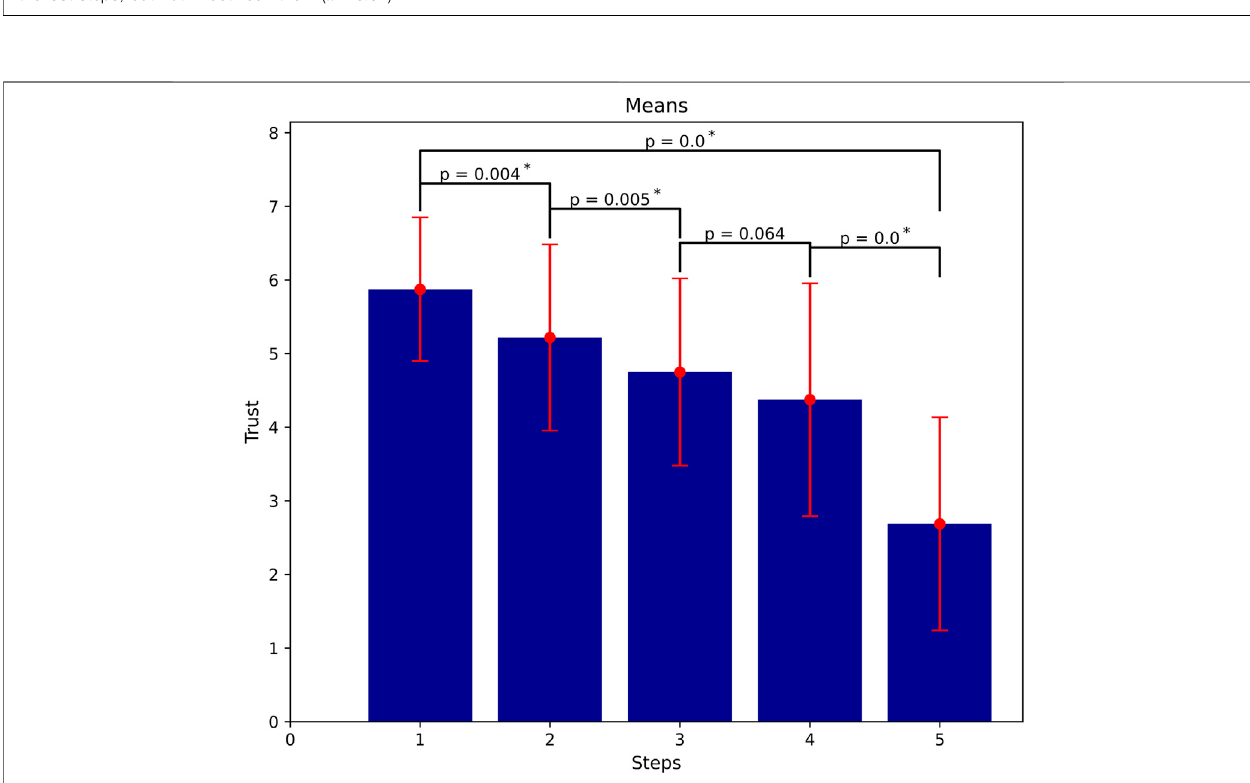
FIGURE 6 | Trust dissipation as more failures occur (means of trust at all steps). Signi fi cant loss of trust mostly even in between steps ( α (cid:1) 0 . 01).